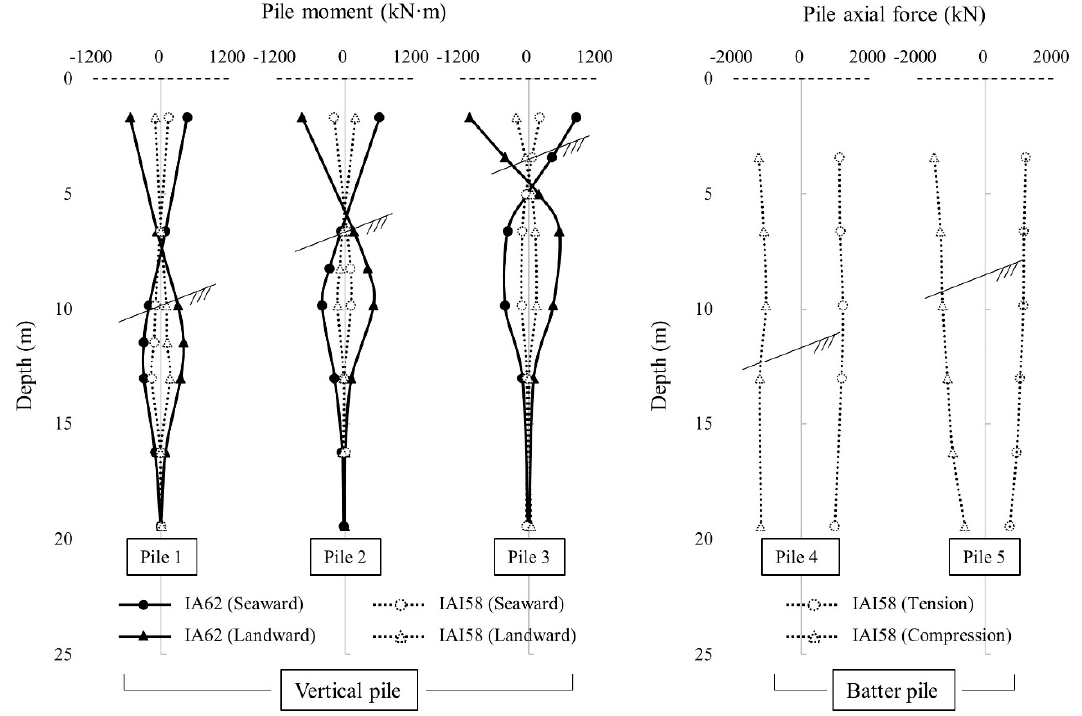
Figure 10. Depth profiles of maximum moment and axial force of horizontal ground model (0.15 g) (scaled to the prototype).